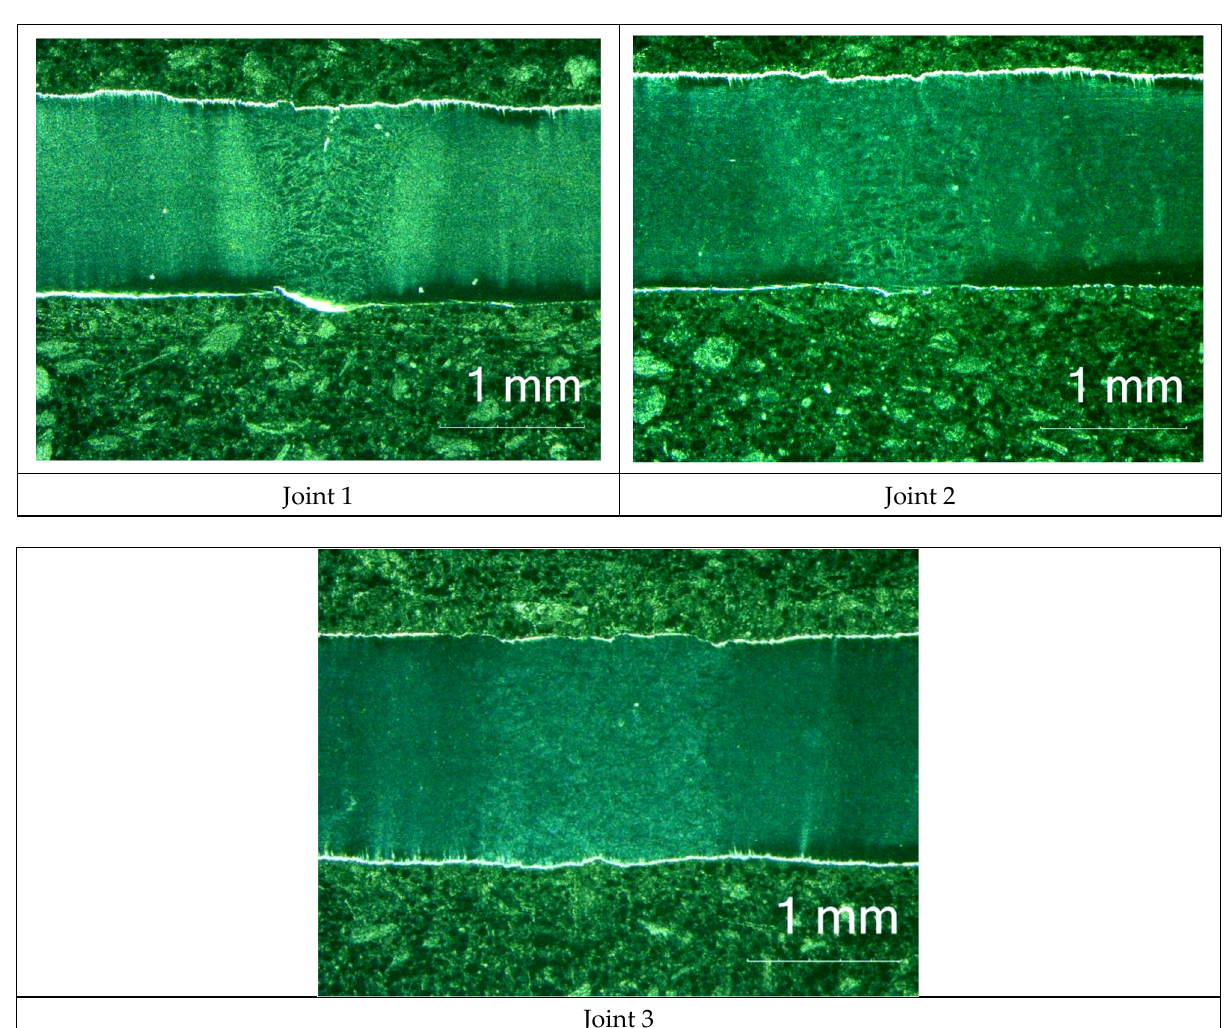
Figure 2. Macrostructure of welded joints.